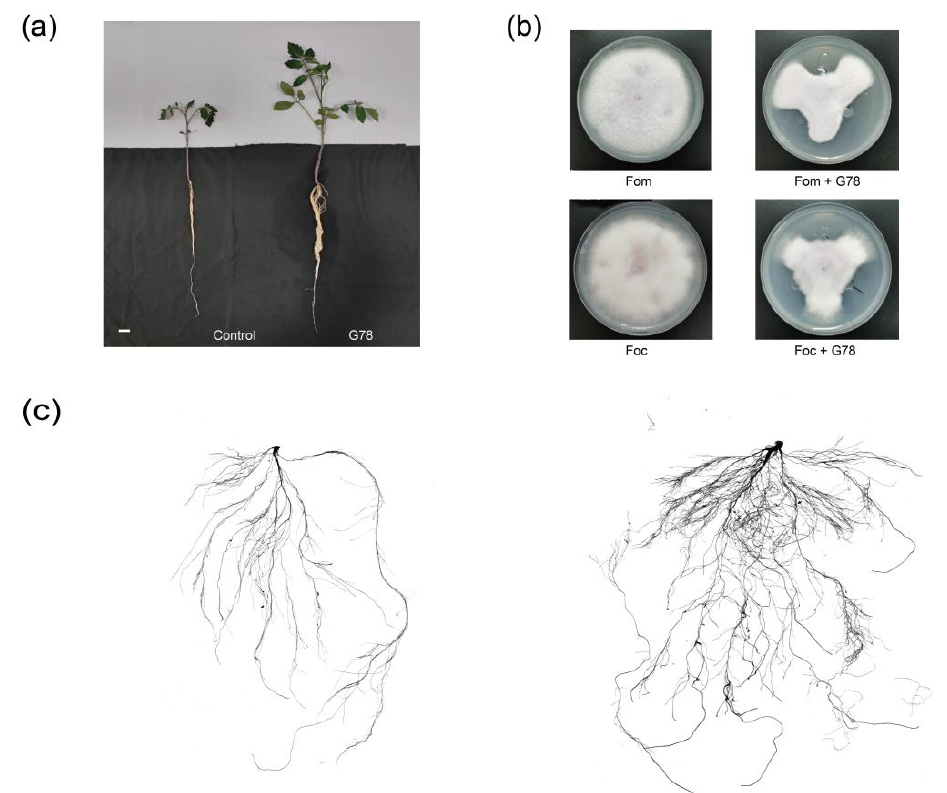
Figure 1. The plant growth promotion ability and antagonistic activity against pathogenic fungi through the dual-culture test of P. mucilaginosus G78 strain. ( a ) The effects of G78 strain on the growth of tomato plant. Bar, 2 cm. ( b ) The growth of F. oxysporum f. sp. momordicae and F. oxysporum f. sp. cubense with or without G78. Fom, F. oxysporum f. sp. momordicae ; Foc, F. oxysporum f. sp. cubense ; Fom+G78 or Foc+G78, F. oxysporum f. sp. momordicae or F. oxysporum f. sp. cubense with G78. ( c ) The root scanning image of tomato plants. G78, the treatment which was inoculated by G78; control, the uninoculated treatment.